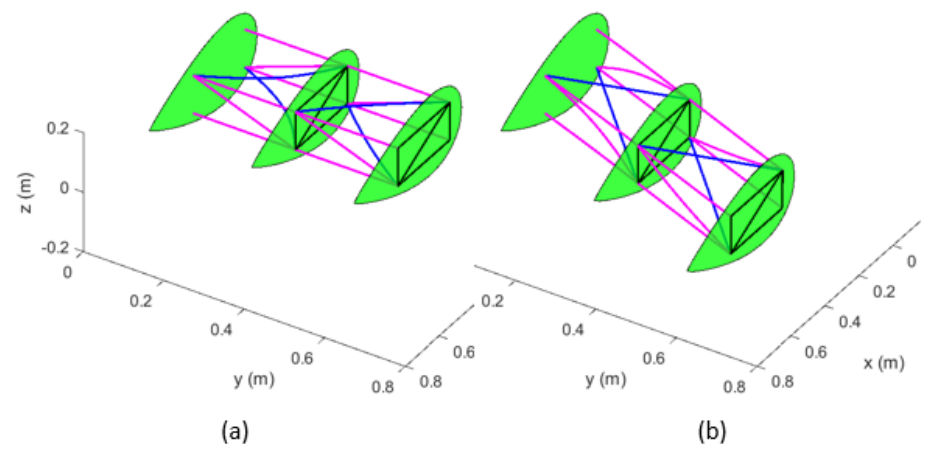
Figure 16. Eighth mode shape for the system in the ( a ) un–morphed configuration, ( b ) morphed configuration (simulation 25).